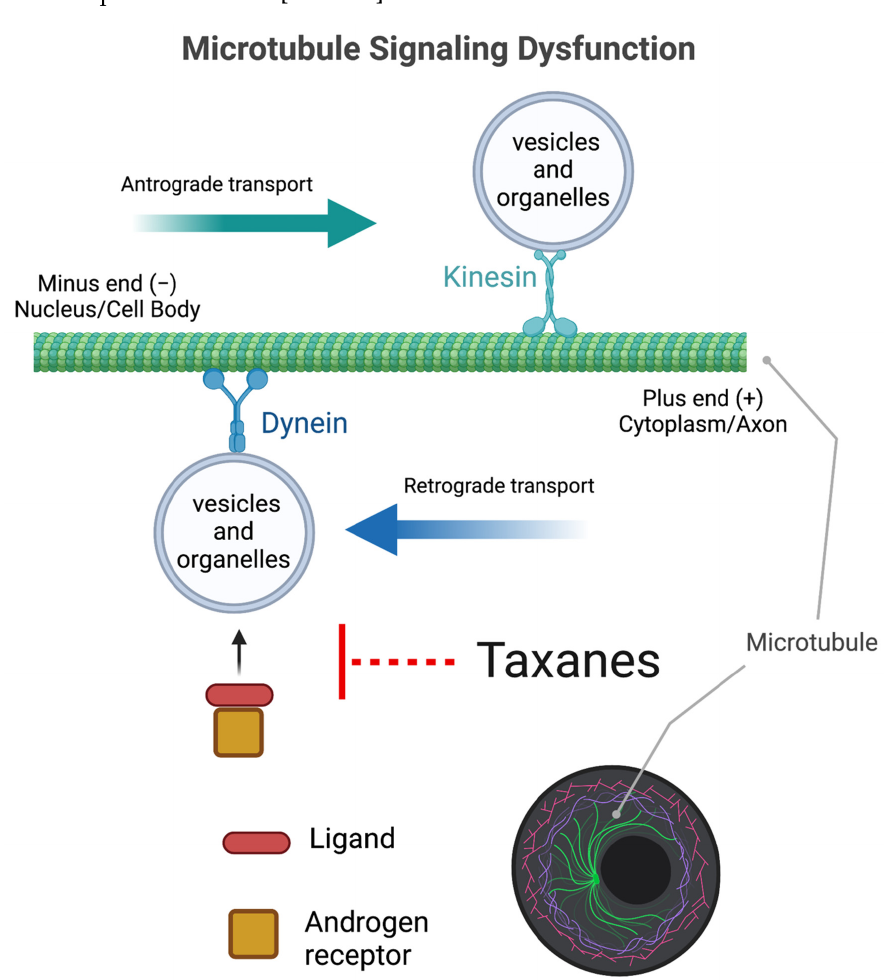
Figure 2. Taxane-induced androgen receptor (AR) microtubule-dependent signaling dysfunction. In the field of prostate cancer research, taxanes are observed to interfere with ligand-mediated AR signaling by inhibiting AR binding to dynein motor proteins, preventing nuclear trafficking of AR. Created with BioRender. Androgen receptor signaling is critical for prostate cancer as well as normal male tissue development, thus providing a potential sex-specific discrepancy in taxane tissue toxicity. AR knockout (KO) mouse studies have not only demonstrated the critical func- tion of AR in male (and female) gonad and gamete development, but also in male body fat, bone, blood, and immune phenotypes [141–144]. Conditional and constitutive ARKO male mice have severe deficits in both innate and adaptive immunity, resulting in pheno- types such as thymus enlargement, immature B-cell populations, and risk of neutropenia and bacterial infections [141]. Although little research has investigated such ARKO phe- notypes in female mice, since ARs dominate signaling function for male sex hormones (while estrogen receptors dominate female sex hormones), taxanes may induce